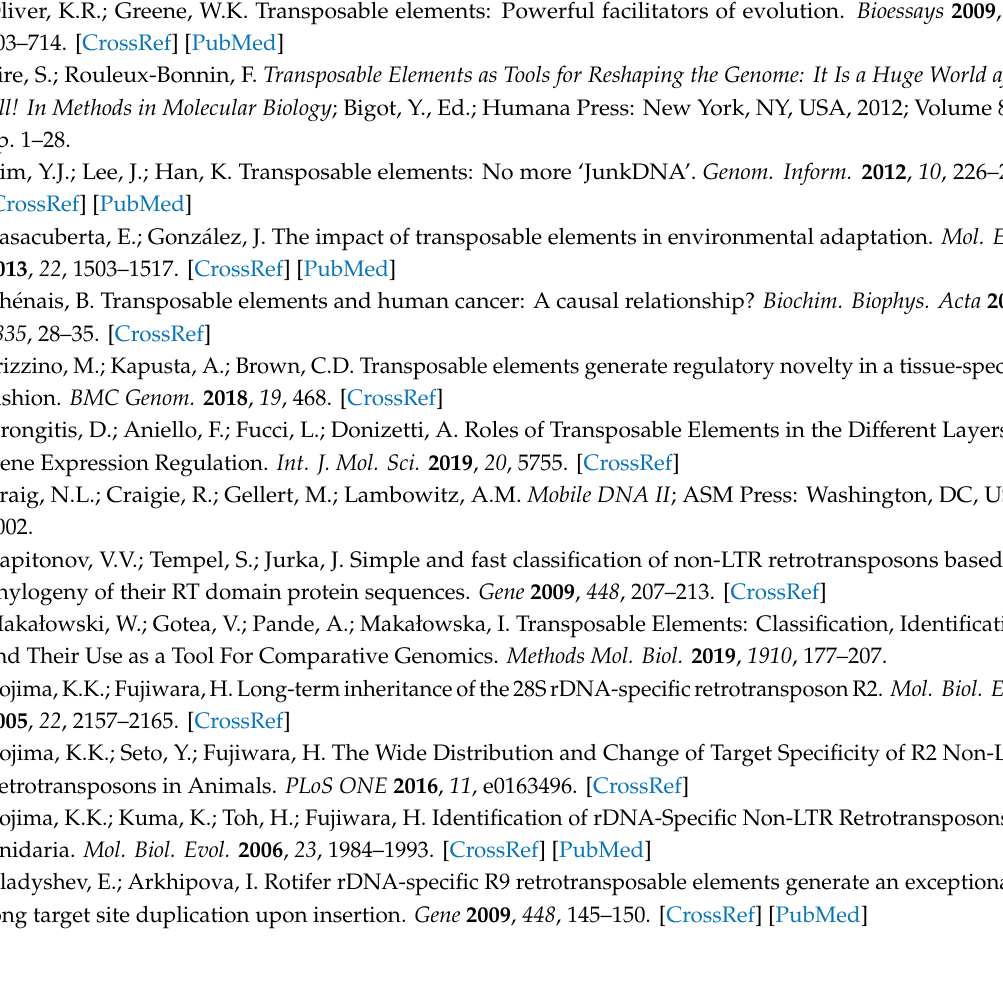
Figure S1. Structural and functional characterization of the R2 retrotransposon of B. germanica ; Figure S2. Structural of the non-site-specific R2 retrotransposons of B. germanica ; Figure S3. Alignment of the nucleotide sequences corresponding to the 5 (cid:48) - and 3 (cid:48) -ends of all identified copies of BLAG 1–BLAG 6 retrotransposons, together with the corresponding sequences of the environments of the integration sites.; Figure S4. Comparison of BLAG 2 and BLAG 6 retrotransposon nucleotide sequences; Figure S5. Comparative analysis of the amino acid sequences of the BLAG 1–BLAG 6 retrotransposons located between the zinc finger domains and the reverse transcriptase domain; Figure S6. Alignment of amino acid sequences used to construct a phylogenetic tree; Figure S7. Population analysis of the structural variants of R2 retrotransposon 5 (cid:48) -truncated